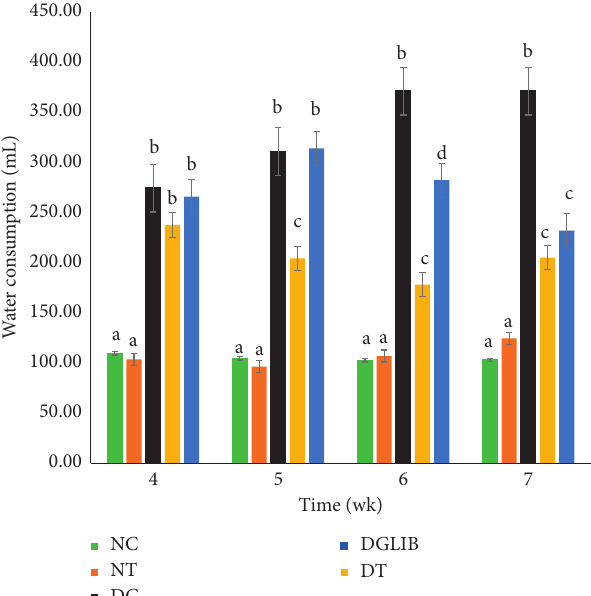
Figure 3: Average daily water intake of diabetic and euglycaemic Sprague Dawley rats in the last four weeks of the study. Data are expressed as mean ± standard error of the mean and analysed by Tukey post hoc statistical test. NC: normal control, NT: normal treatment, DC: diabetic control, DT: diabetic treatment, and DGlib: diabetic glibenclamide group, where the letters represent the following: a, statistically significant differences when compared with the bars with letters b, c, and d; b, statistically significant differences when compared with the bars with letters a, c, and d; c, statistically significant differences when compared with the bars with letters a, b, and d; d, statistically significant differences when compared with the bars with letters a and b. Significant difference is considered at p ≤ 0 . 05. Table 1: Variation in serum insulin, glucagon, and insulin resistance in treated and untreated diabetic and nondiabetic Sprague Dawley rats. NC NT DC DGLIB DT Serum insulin levels (ng/mL) 0.49 ± 0.06 a QUICKI 0.336 ± 0.006 a 0.334 ± 0.002 a Data are expressed as mean ± standard error of the mean and analysed by Tukey post hoc test. NC: normal control, NT: normal treatment, DC: diabetic control, DT: diabetic treatment, and DGlib: diabetic glibenclamide group, where the letters represent the following: a, statistically significant differences when compared with the values in the same row with superscripts b; b, statistically significant differences when compared with the values in the same row with superscripts a. Significant difference is considered at p ≤ 0 .